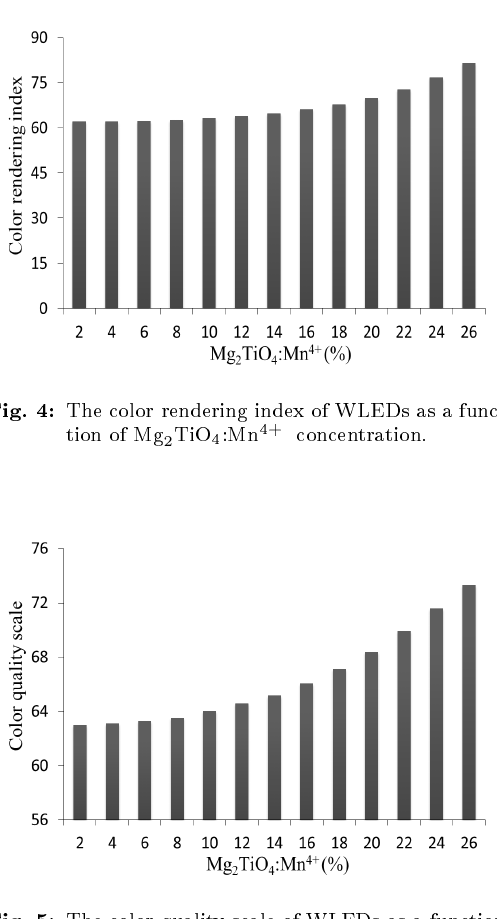
Fig. 5: The color quality scale of WLEDs as a function of Mg 2 TiO 4 :Mn 4+